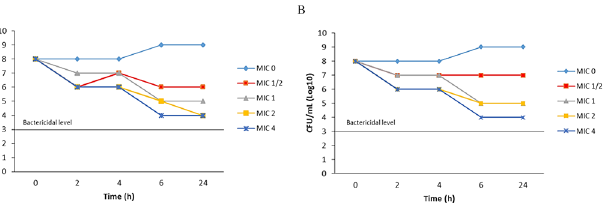
Fig 5. Time killing kinetics. (A) Shown are growth curves of S . aureus ATCC 25923 and (B) MRSA ATCC BAA-1720 strains bacteria cells grown and evaluated by counting colony forming units (CFU) within different intervals of time (0, 2, 4, 6 and 24 hours) of incubation in MHB II medium at 37°C in the absence or presence of increasing concentrations of artonin E (MIC ½ , 1, 2 and 4) added at OD 600 nm of